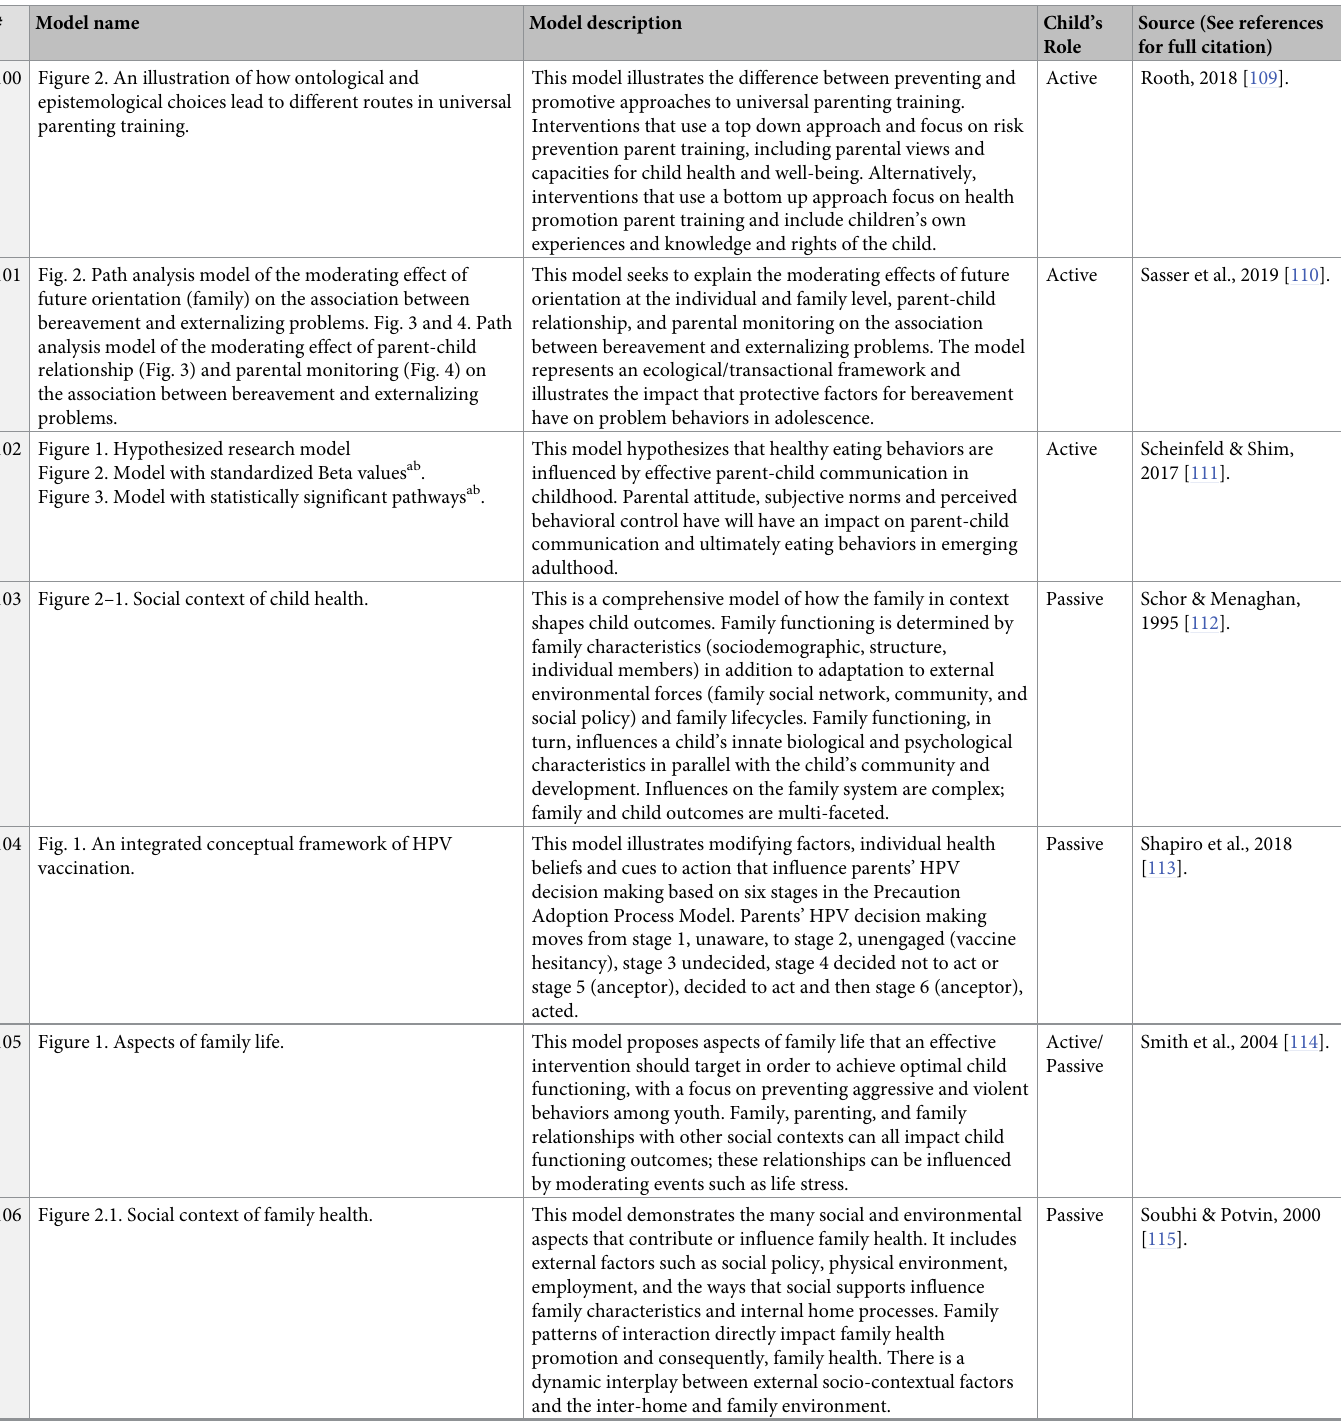
100 Figure 2. An illustration of how ontological and epistemological choices lead to different routes in universal parenting training.